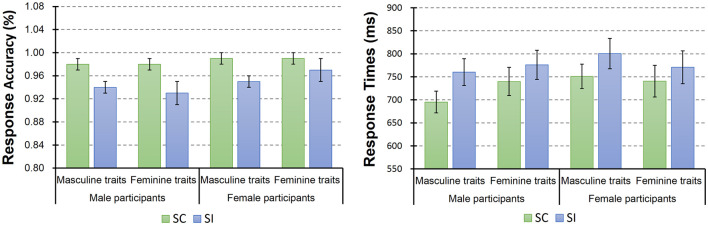
Descriptive statistic results of participants’ task accuracy and response times. The column and bar in this figure denoted the mean and standard error (i.e., mean ± SE), respectively. The statistical analysis on participants’ response accuracy showed a significant main effect of the stereotype compatibility, where SC trials gained higher accuracy than SI trials. In addition, the statistical analysis on response times revealed a significant main effect of the stereotype compatibility and also a significant participant’s gender × trait’s gender preference interaction. Post hoc tests showed that participants on average responded significantly faster to the SC trials than the SI trials. Additionally, male participants showed a trend that they responded faster to the masculine traits than feminine traits (see right figure).